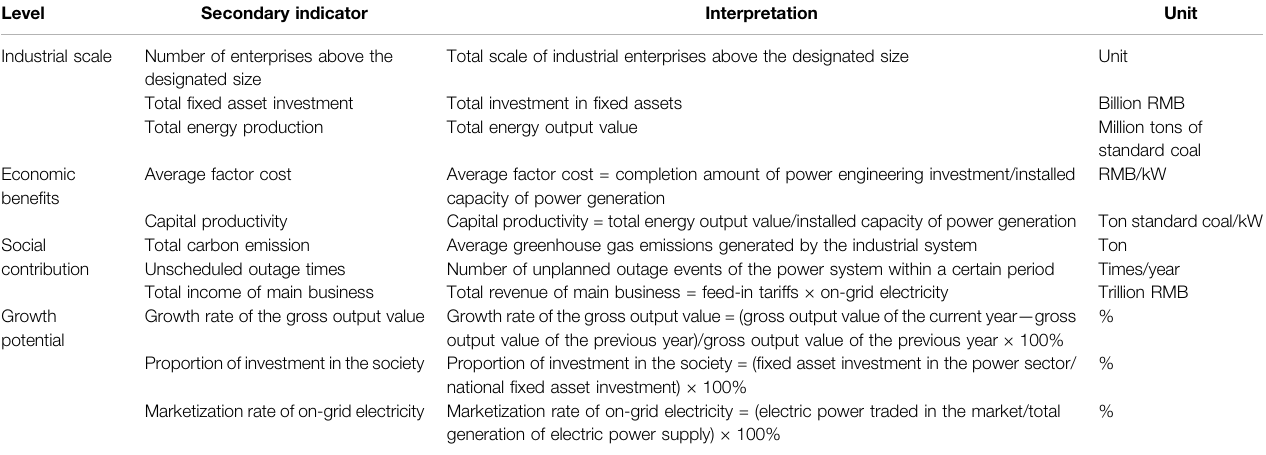
TABLE 1 | Indicator system of the comprehensive development level for the conventional and nonconventional energy